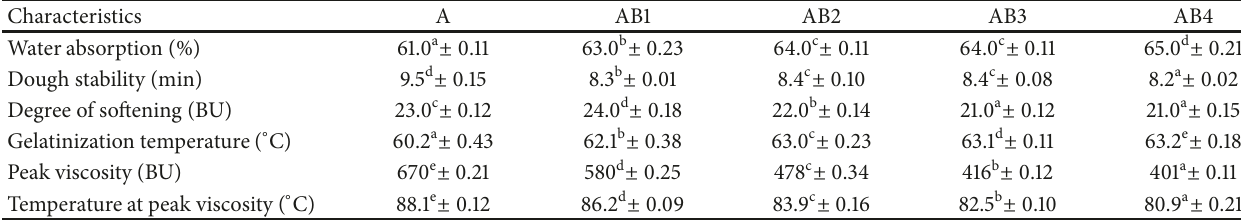
Table 3: Farinograph and Amylograph readings of wheat and walnut bread